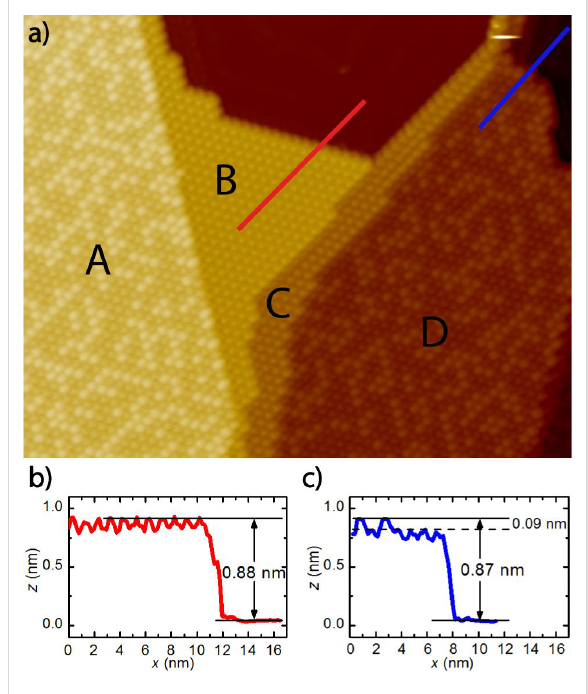
Figure 1: (a) (54.5 × 40.5 nm 2 ) STM image of uniform (marked by B and C) and disordered R30° domains (A and D) ( U bias = 1.1 V, I T = 0.18 nA; sample A2). Linescans measured along the indicated red (b) and blue line (c) in Figure 1a reveal that the apparent height differ- ences between a uniform R30° domain and the Au(111) surface or between a disordered R30° domain and the Au(111) surface, respect- ively, are comparable at U bias = 1.1 V. The apparent height difference between bright and dim C 60 in disordered R30° domains corresponds to approximately 0.09